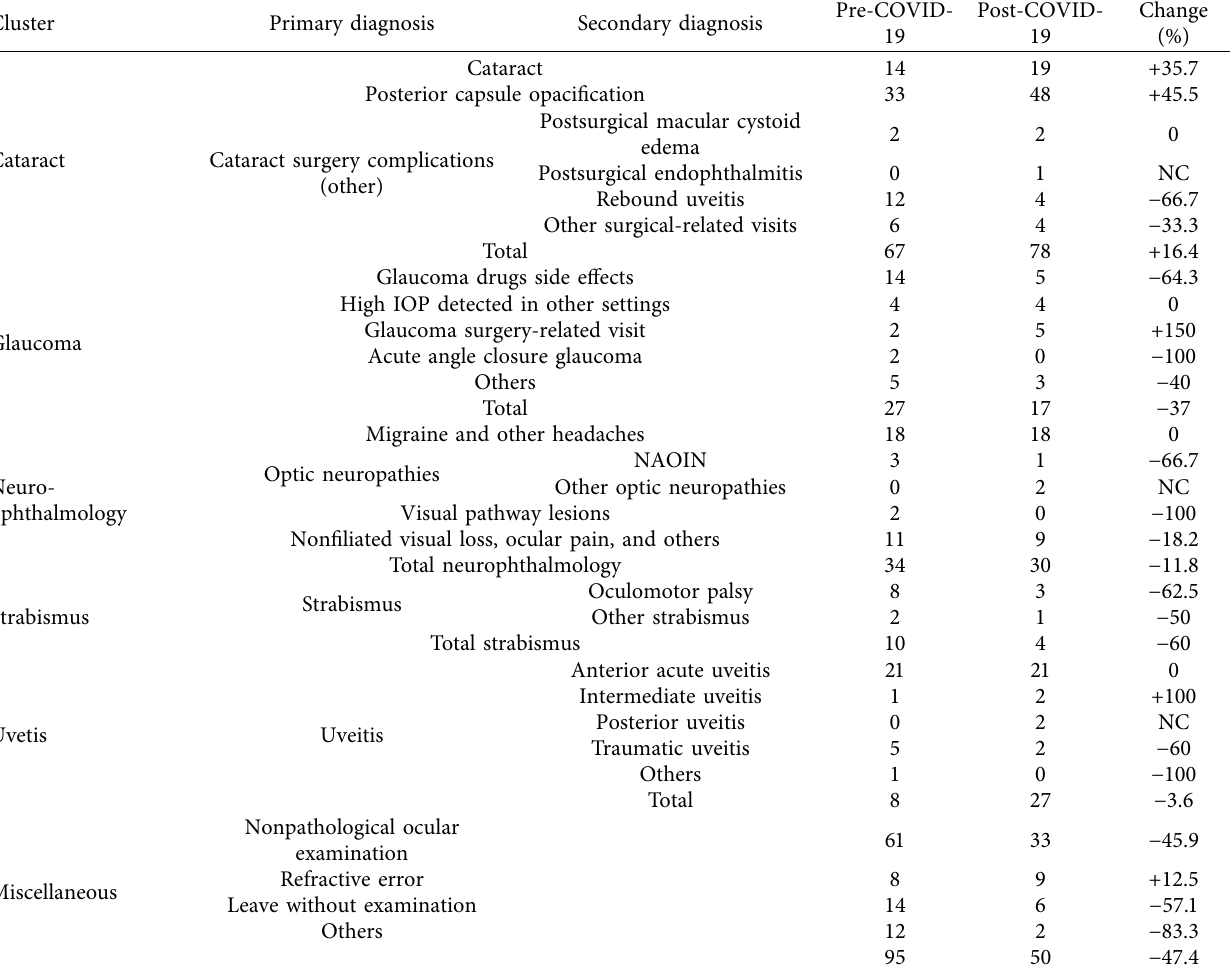
Table 3: Diagnosis distribution of the less prevalent clusters.